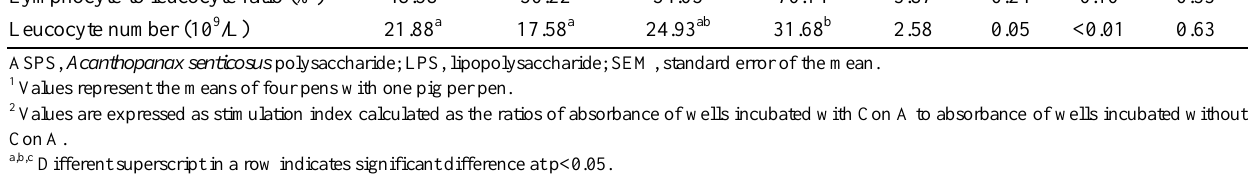
Table 3. Effect of dietary ASPS supplementation on peripheral immune parameters of weaned piglets challenged with LPS 1 Items